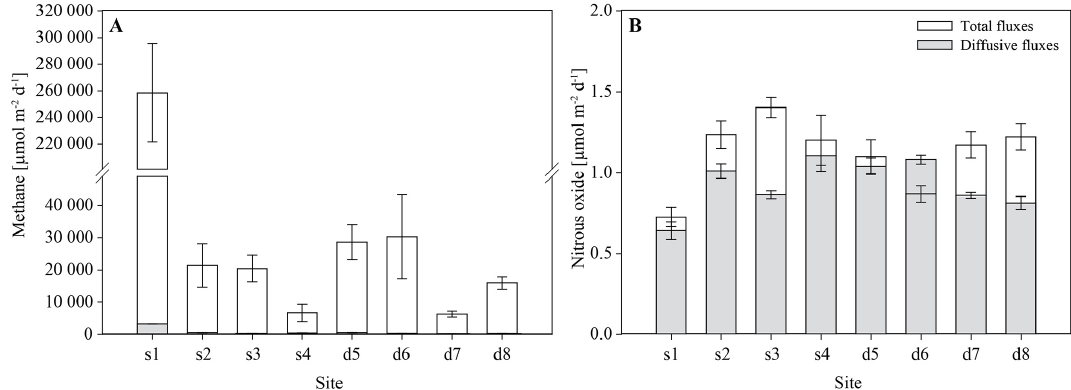
Figure 3. Total and diffusive methane (a) and nitrous oxide (b) fluxes at sampling sites s1–s4 and d5–d8. Total fluxes were determined using the anchored surface floating chambers, and diffusive fluxes were determined using the thin boundary layer model. Rates per site were averaged over three surface floating chamber deployments. Sampling sites are numbered from shallowest to deepest. Fluxes are given as average ± SE, n =